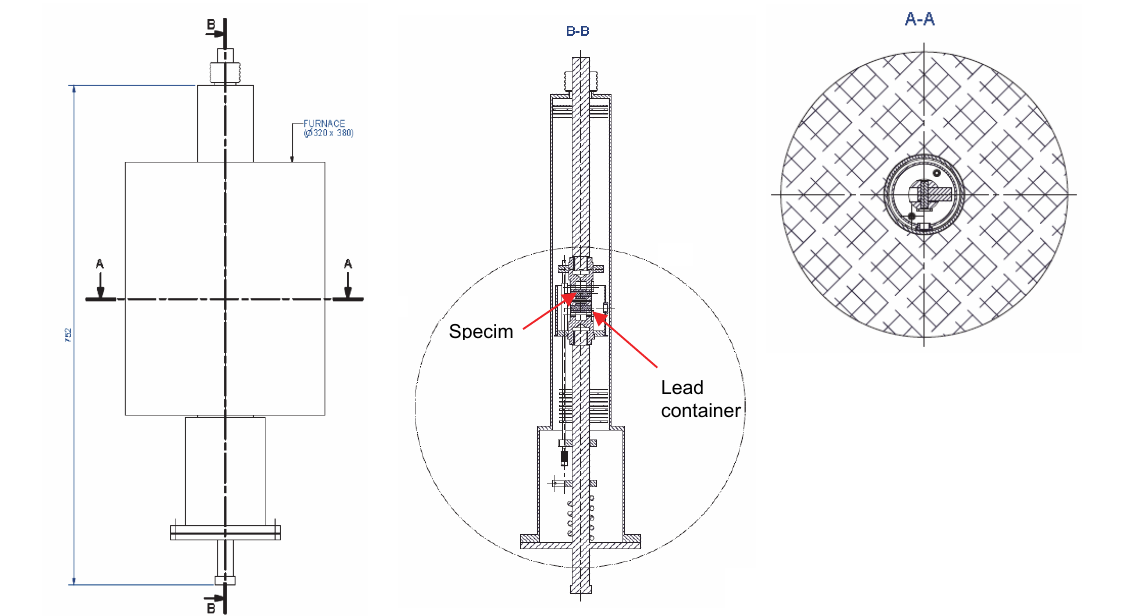
Figure 2: overall sketch of testing cell with both the longitudinal and cross sections.